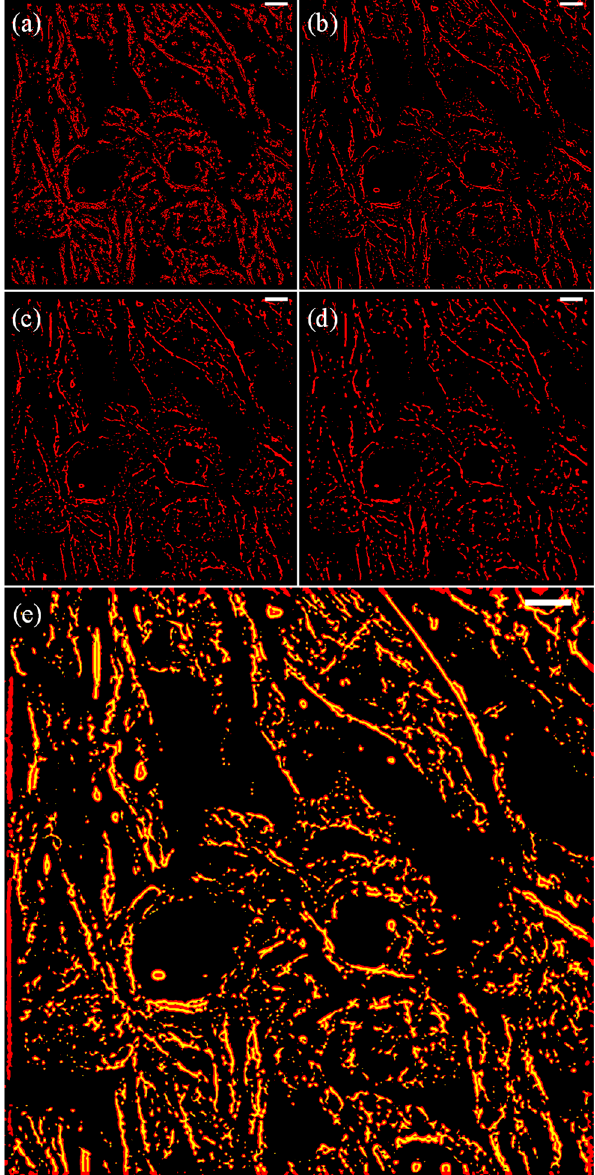
Figure 10. Different empirical coefficients corresponding to the deconvolution results. White scale bars represent 10 µ m. ( a ) ξ = 0.5; ( b ) ξ = 2.5; ( c ) ξ = 4.5; ( d ) ξ = 6. ( e ) The comparison between pre-processing and post-processing of the logic matrix used to extract the microtubule structure in the original image. Here, ξ = 2.5 is applied. The white scale bars represent 10 µ